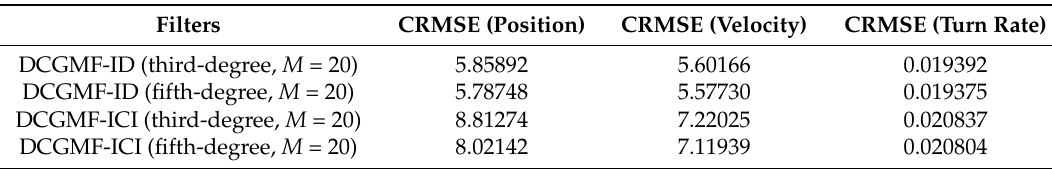
Table 1. Cumulative root mean square errors (CRMSEs) of different